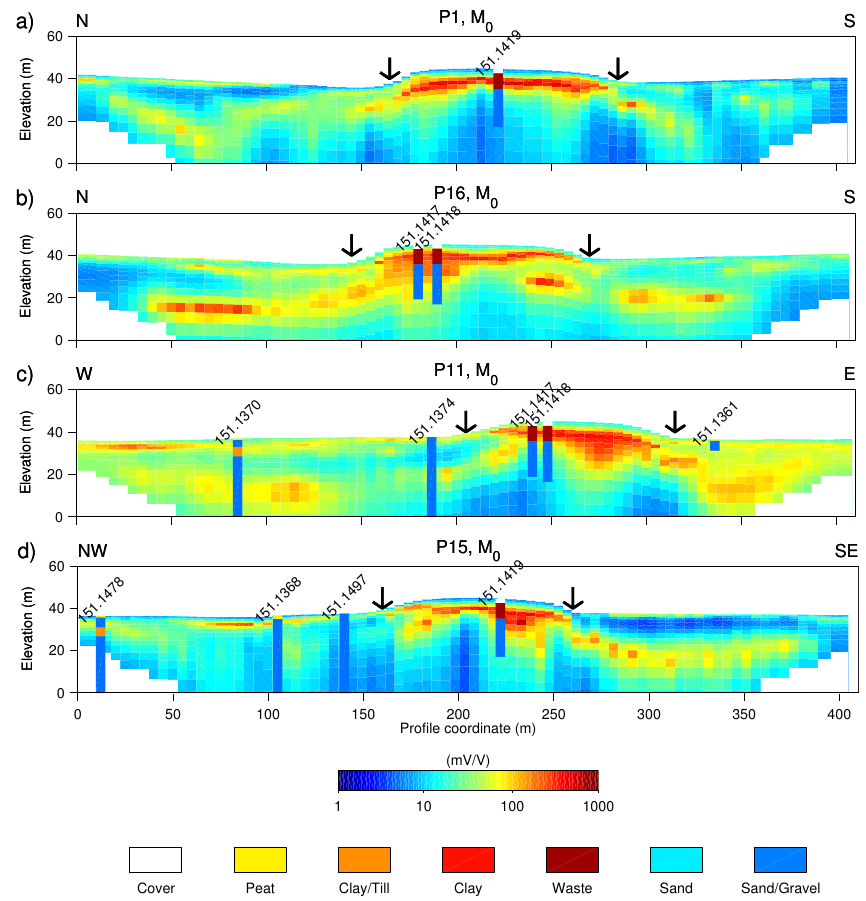
Fig. 6. Inverted sections in chargeability crossing the landfill with superimposed boreholes. The landfill is located within the arrows. High chargeability is coloured